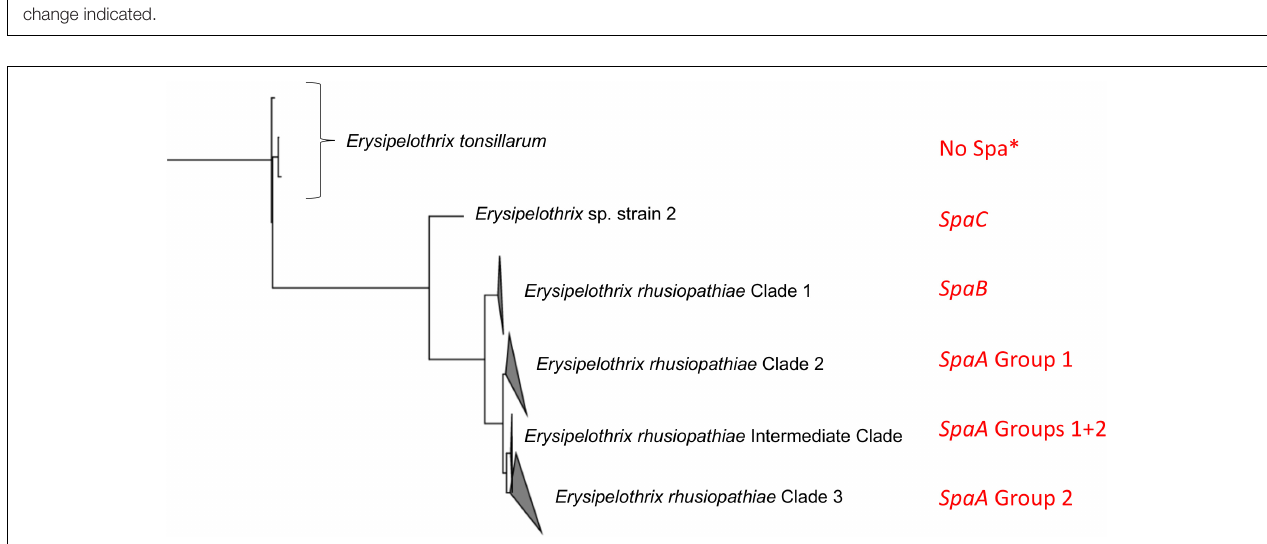
FIGURE 5 | Relationship of Spa type and SpaA group to the population structure of Erysipelothrix spp. This figure is adapted from Forde T. et al., 2016. The tree is rooted to other genera of the family Erysipelotrichaceae. Spa type and SpaA group are indicated in red. SpaA group is based on discriminatory amino acid variants ( Figure 4 ). ∗ spaA and spaB have been reported only once each in Erysipelothrix tonsillarum ( Pomaranski et al.,